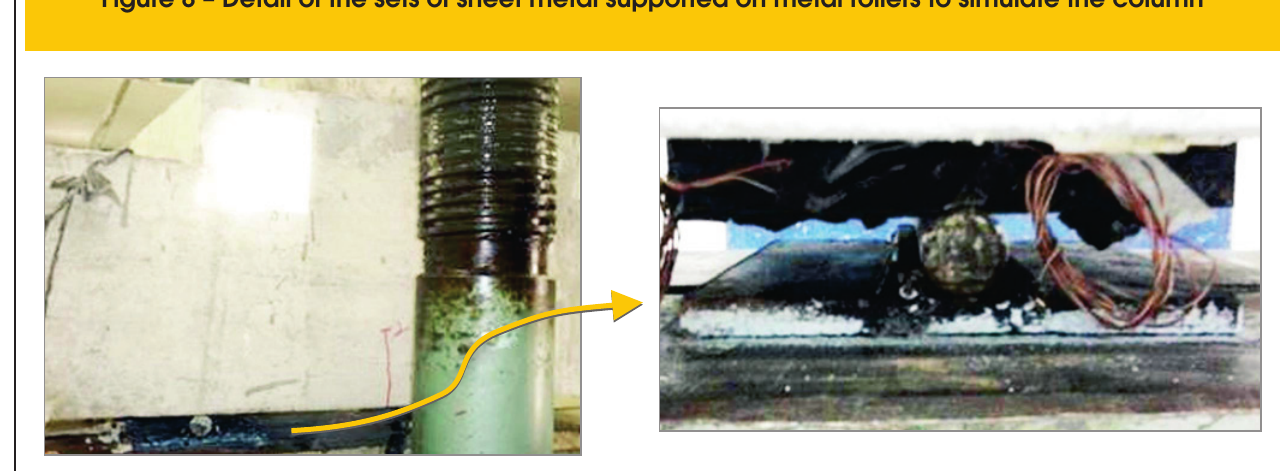
Figure 8 – Detail of the sets of sheet metal supported on metal rollers to simulate the